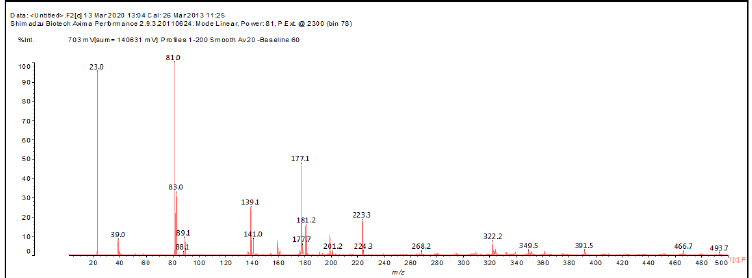
Figure 1. Matrix assisted laser desorption ionization time-of-flight spectrometry (MALDI ToF) spectrum of humins obtained at 180 °C from fructose, 20 – 500 Da range.